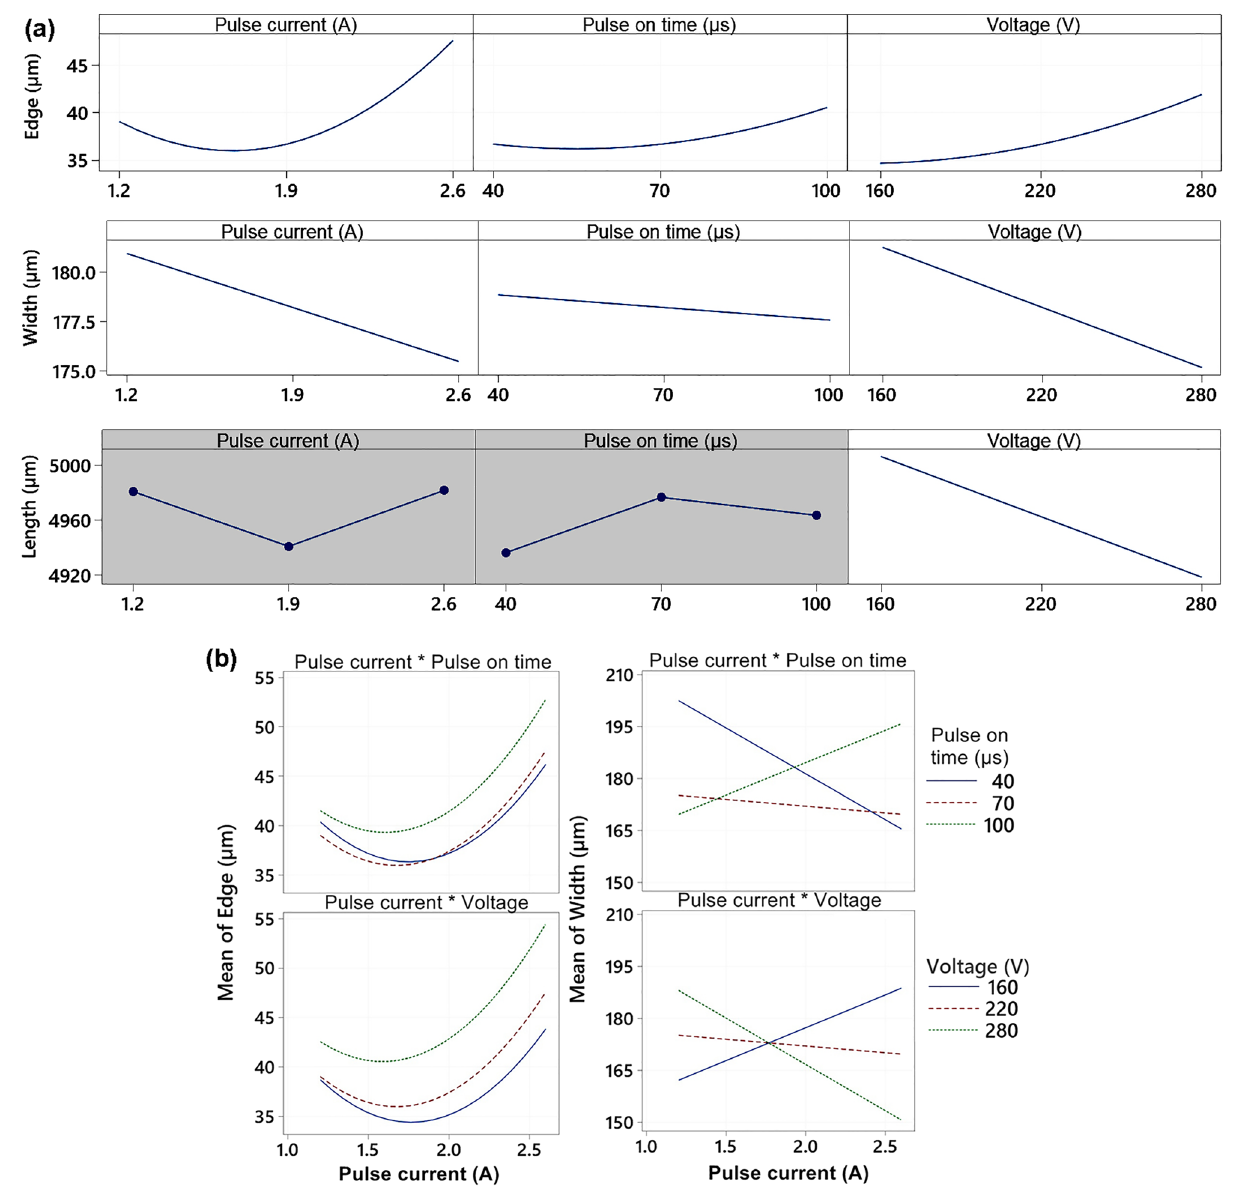
Figure 4. ( a ) Main Effect Plots for Edge, Width and Length (A grey background represents a term not in the model, which is not statistically significant and is therefore not included in the model) ( b ) Interaction plots for significant